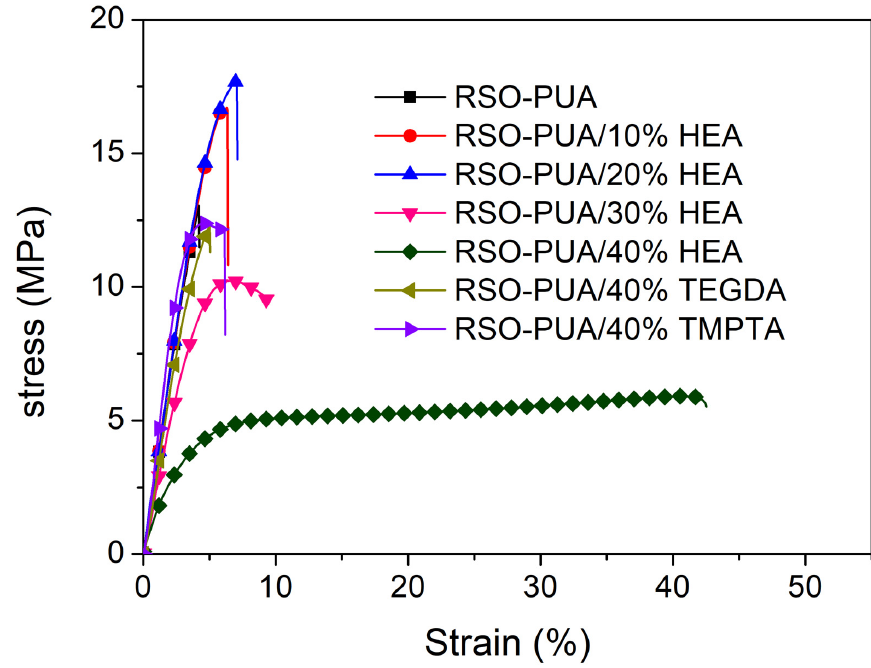
Table 3. Mechanical properties and coating properties of the cured RSO-PUA resins.